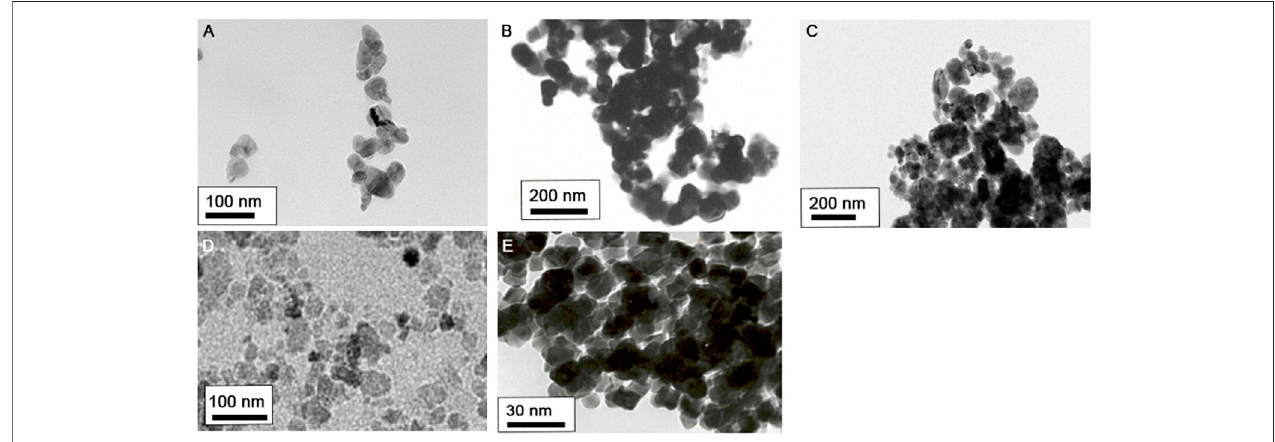
FIGURE 1 | Morphology of fi ve metal oxide NPs observed by transmission electron microscopy (TEM): (A) CoO, (B) Co 3 O 4 , (C) CuO, (D) NiO, and (E) TiO 2 NPs.